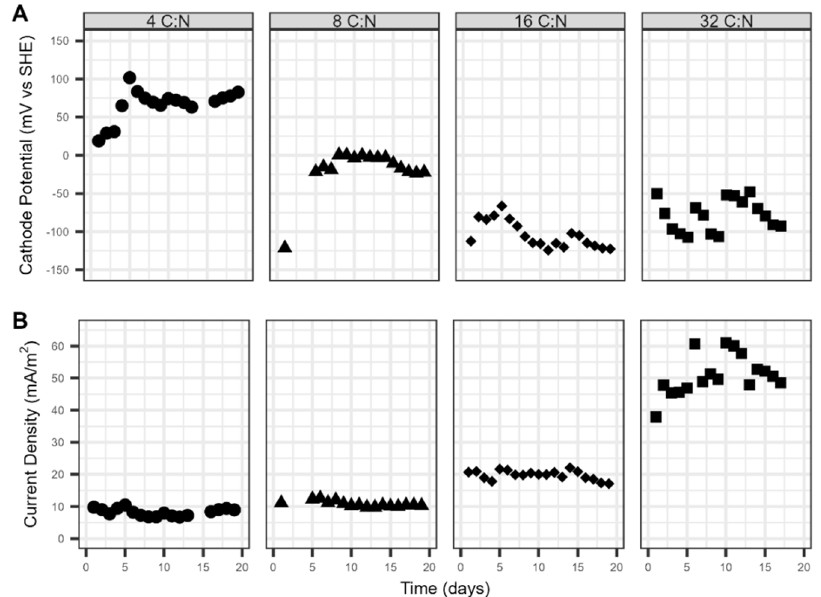
Figure 4. Electrochemical performance of MFCs depicting ( A ) cathode potential and ( B ) current density when operated under C:N ratios of 4, 8, 16, and 32 in Phase II.